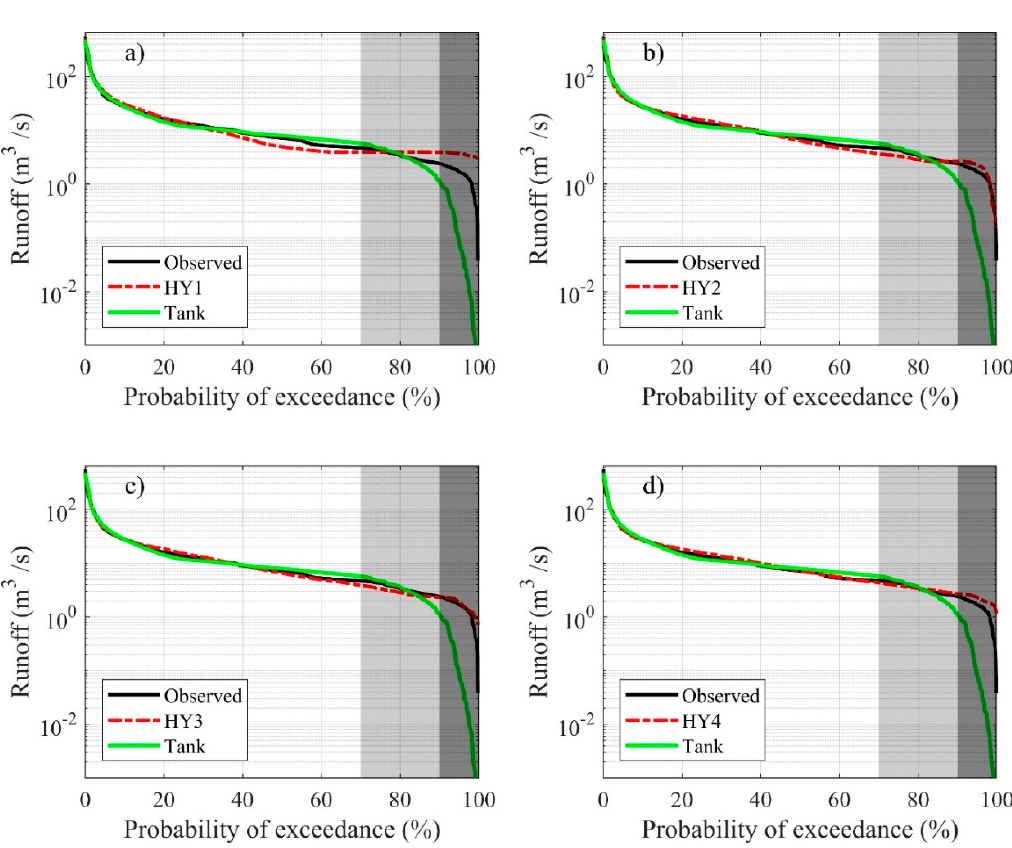
Figure 12. Flow duration curve comparison between four different Tank-LSSVM models, the tank model, and direct observation data during the testing period (2014-2016). Here, the light and dark shaded areas represent 70% and 90% exceedance percentiles of the observed runoff.